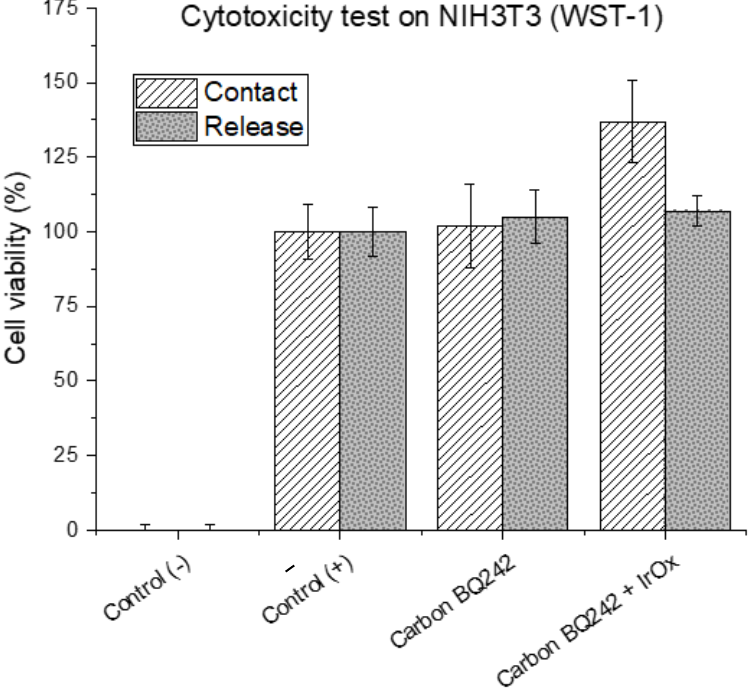
Figure 3. Cytotoxicity testing on NIH3T3 cells (WST-1) of electrode’s materials (carbon BQ242 and carbon BQ242 + IrOx 2 wt%). Values of cell viability (in %) represent the average absorbency ( n = 3) ± SEM, relative to positive controls (+) cultures (without any contact with any materials). Negative controls ( − ) correspond to the cultures where cells are exposed to hydrogen peroxide (H 2 O 2 , 10 mM), in which no cell growth and proliferation is expected (dead cells control).